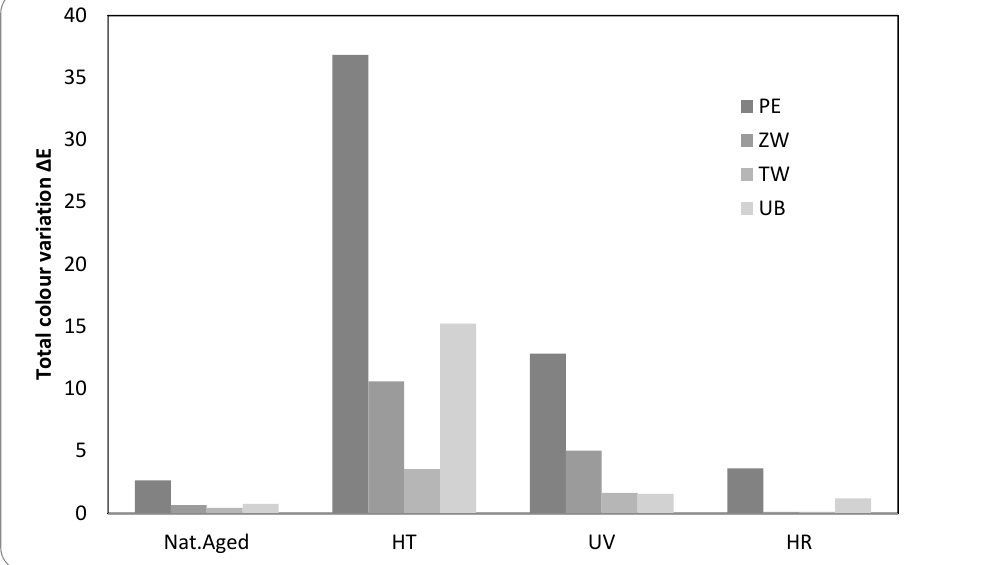
Table 4. Colour changes calculated as Δ E, Δ L*, Δ a* and Δ b* after natural and accelerated ageing. Mock-ups